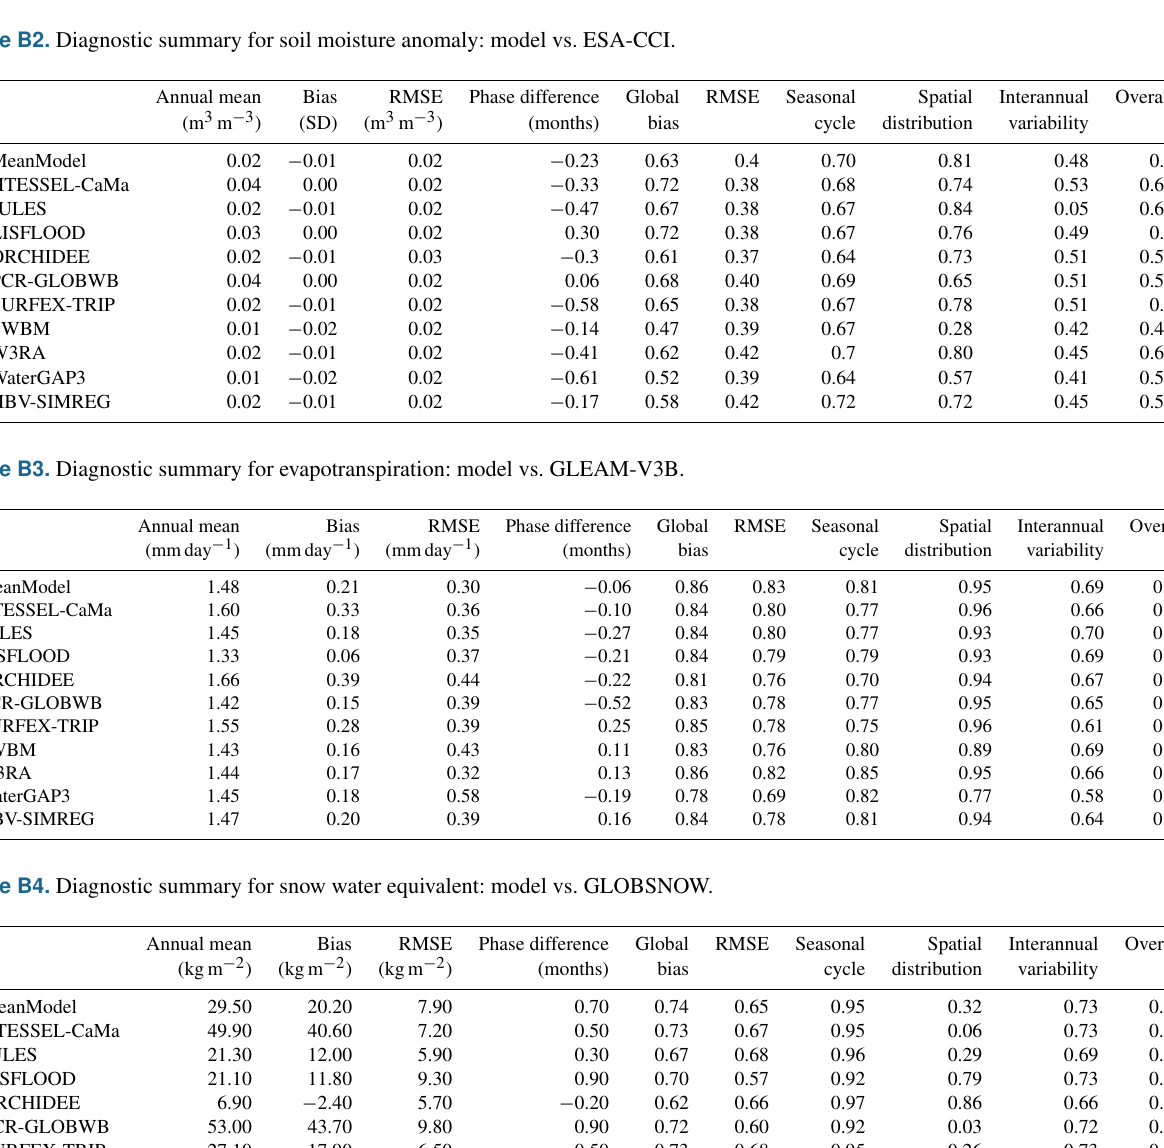
Table B2. Diagnostic summary for soil moisture anomaly: model vs. ESA-CCI. Annual mean MeanModel